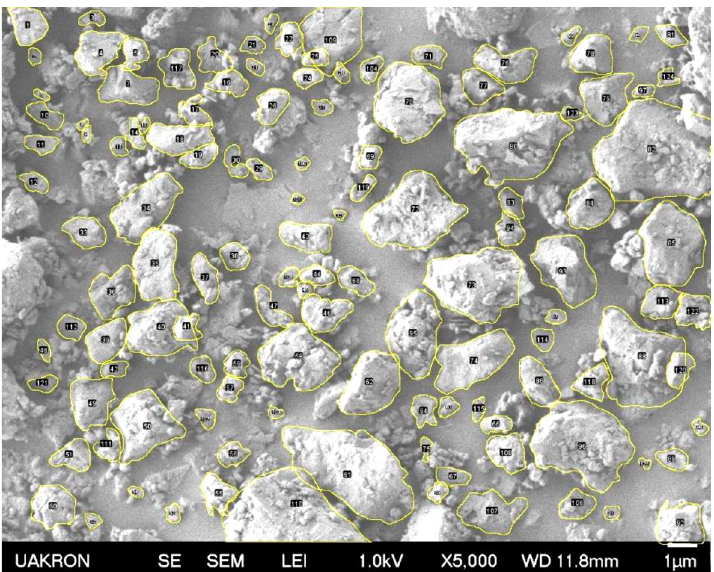
Figure 4. SEM image of GSBH-A particles. The outlined particles were used by the ImageJ software to determine their particle size.